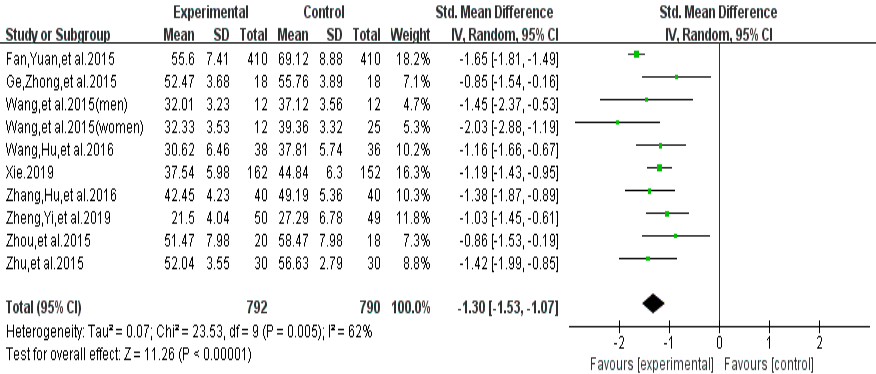
Figure 2. E ff ect of exercises on total score of smartphone Figure 2. Effect of exercises on total score of smartphone addiction.